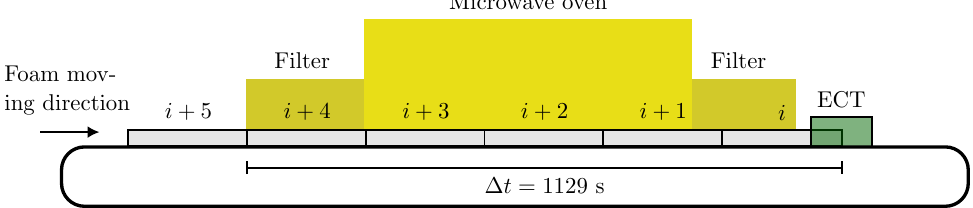
Figure 4. The schematic of the continuous drying process of polymer foams. The gray rectangles indicate the polymer foams with a length of 150 cm and thickness of 3 cm while passing first through the oven and then the ECT sensor with a speed of 40 cm/min. It took 1129 s for every foam to travel from the entrance point and reach the ECT